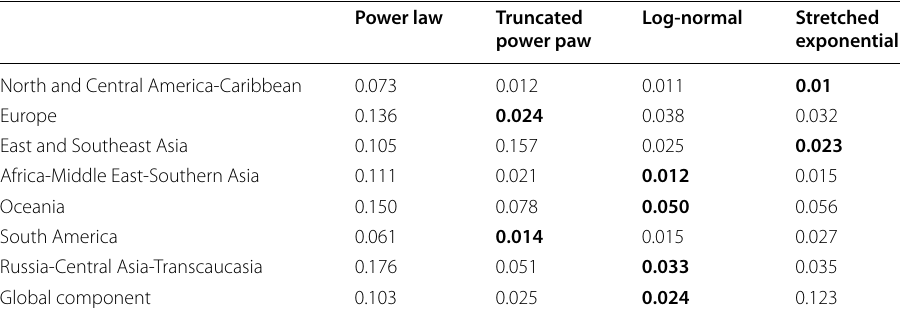
Table 4 Kolmogorov–Smirnov goodness of fit values (KS-test) for the degree distribution of the